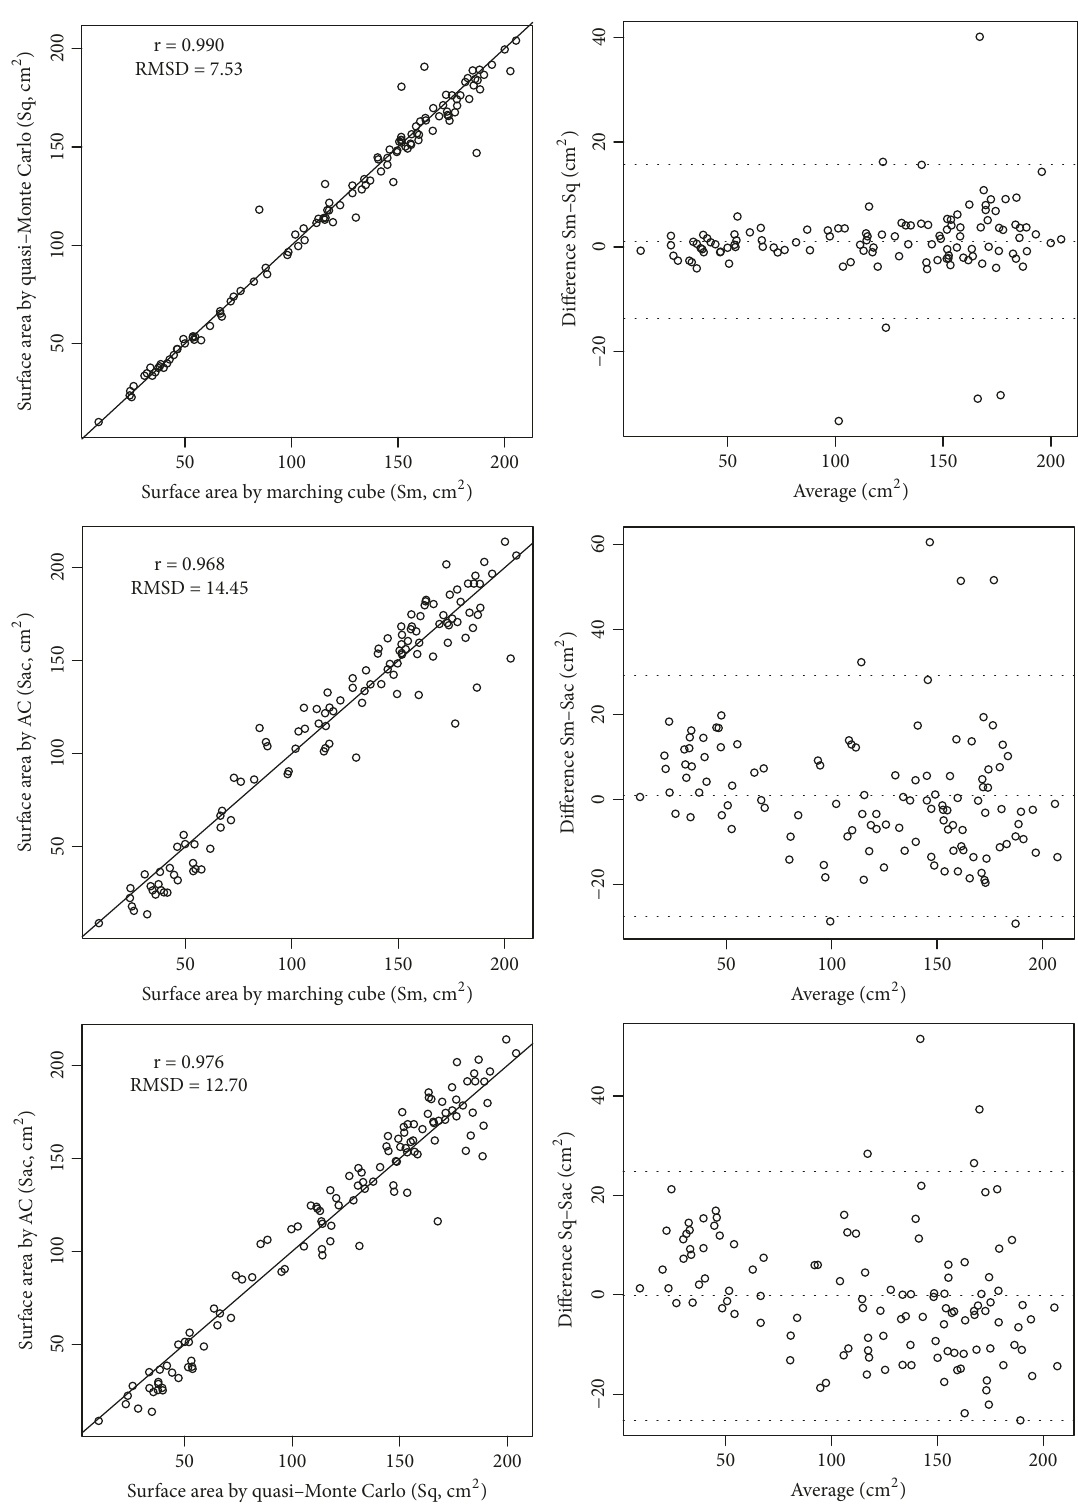
Figure 3: Data plots with the line of equality and Bland-Altman analyses between the craniectomy area estimated using the marching cube (Sm), quasi-Monte Carlo (Sq), and AC (Sac) methods. RMSD: root-mean-square